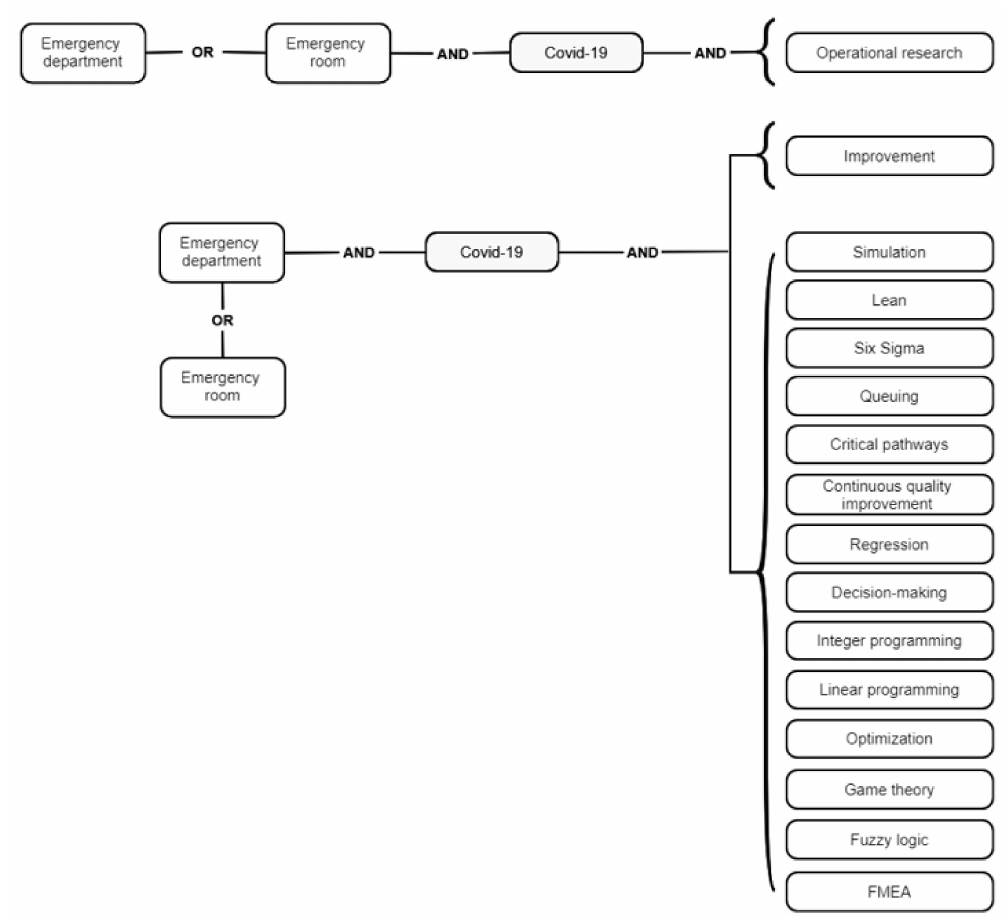
Figure 1. Search algorithms used in the literature